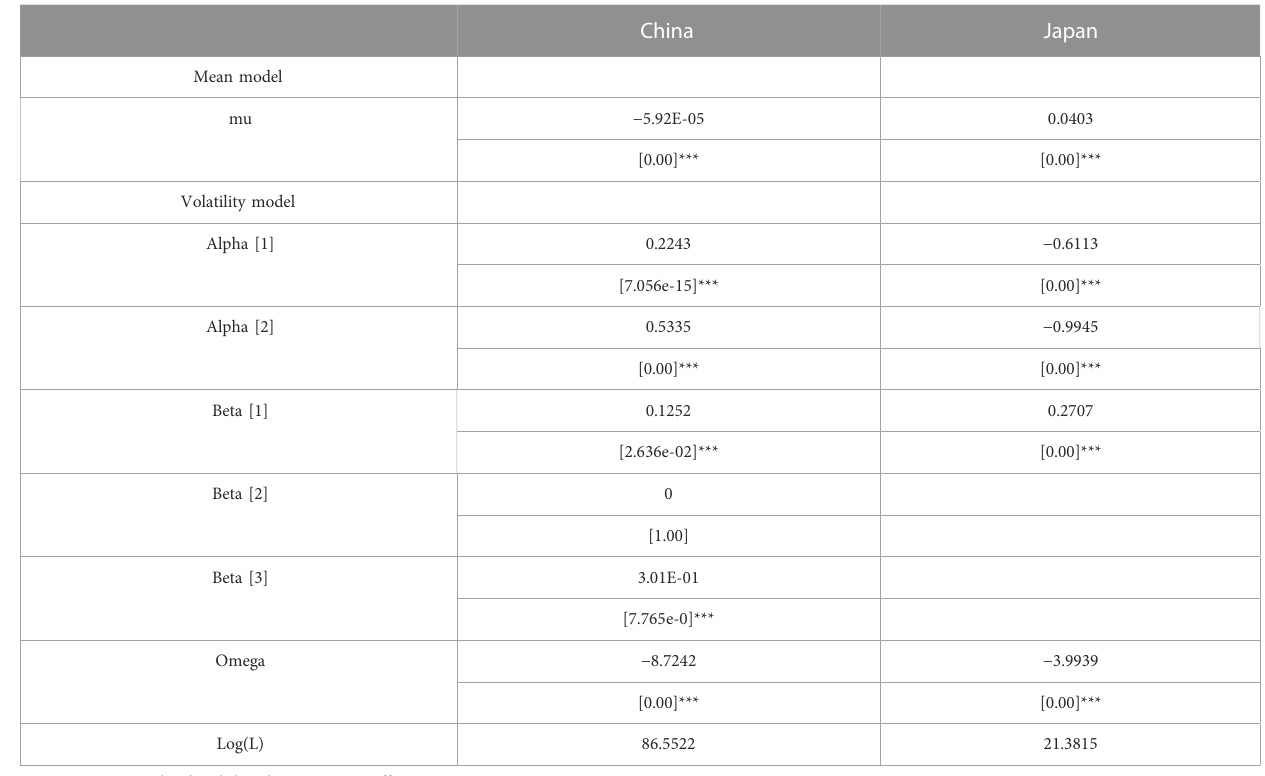
TABLE 11 Results of the EGARCH model in China and